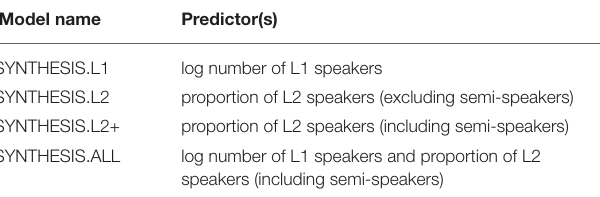
TABLE 2 | Model names and predictors in case study